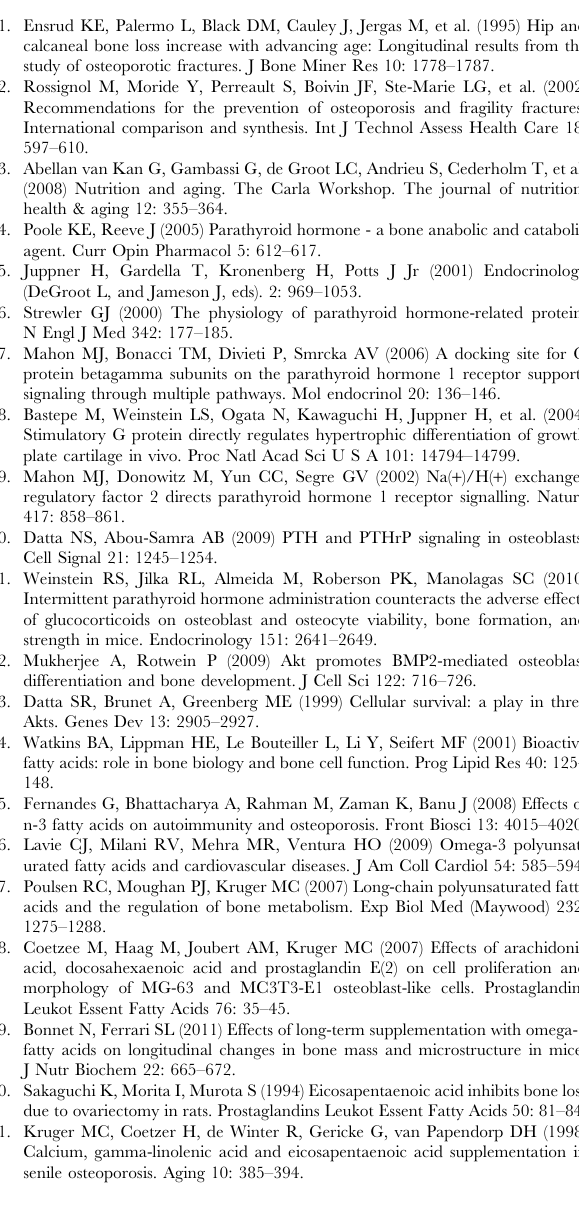
Figure S1 pERK levels in HEK393 and MC3T3 untrans- fected or transfected with the empty plasmid pcDNA3.1.